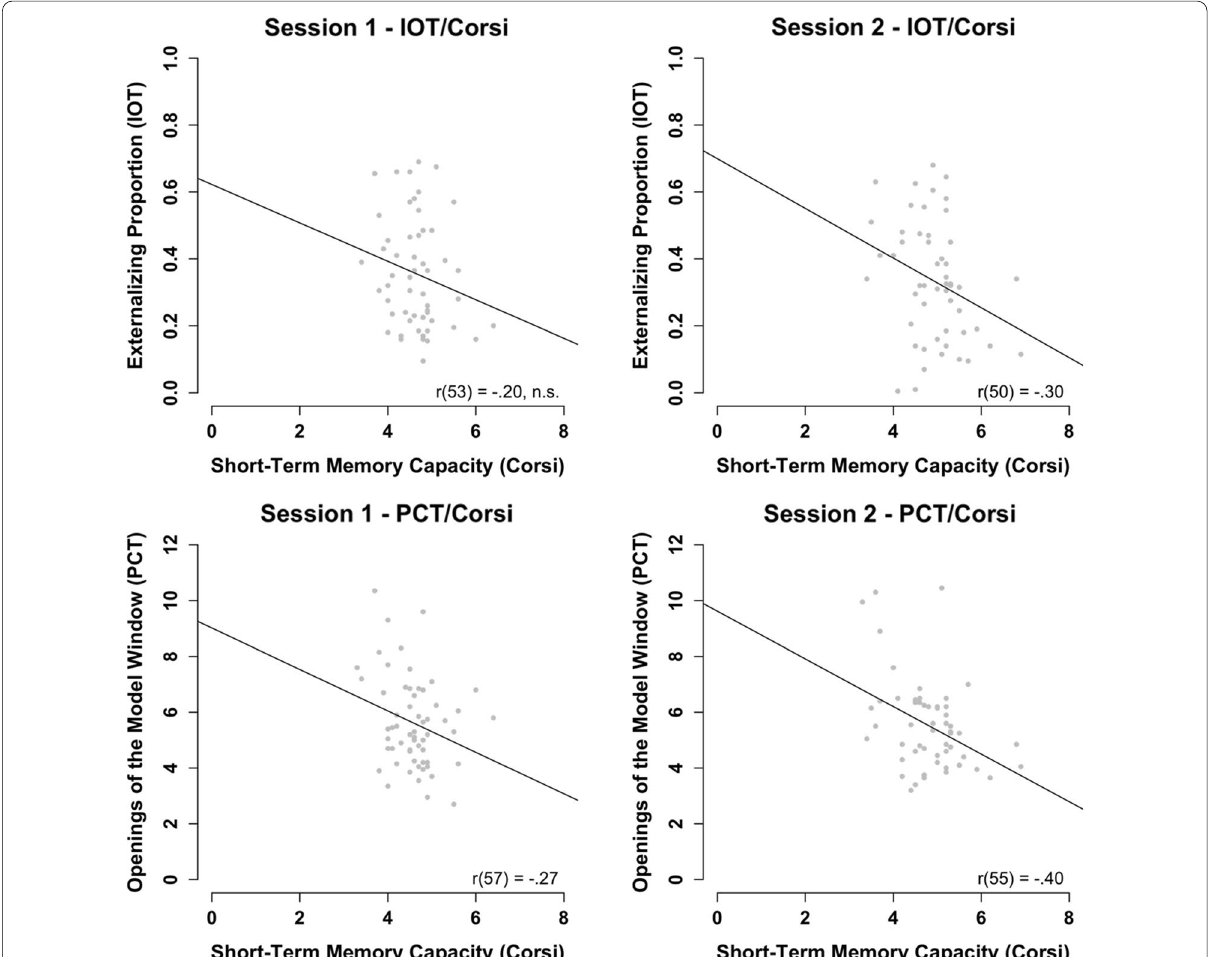
Fig. 5 Correlations between offloading measures of the intention offloading task (IOT; upper panels) and the pattern copy task (PCT, lower panels) with short-term memory capacity measured by the Corsi blocks task separately for the first session (left panels) and the second session (right